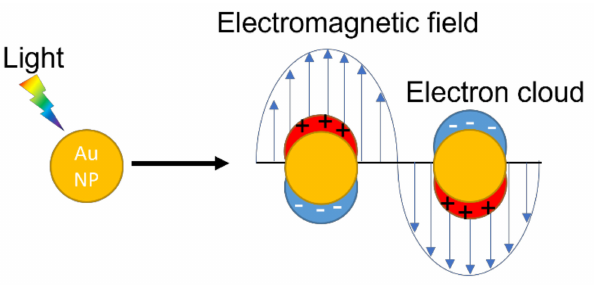
Figure 1. The scheme of interaction of electromagnetic wave with the surface electrons of AuNP to induce the LSPR effect.